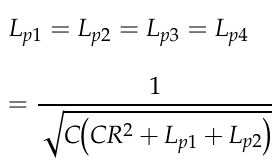
Figure 7. Layout diagram for 1st-order poly-phase filter.